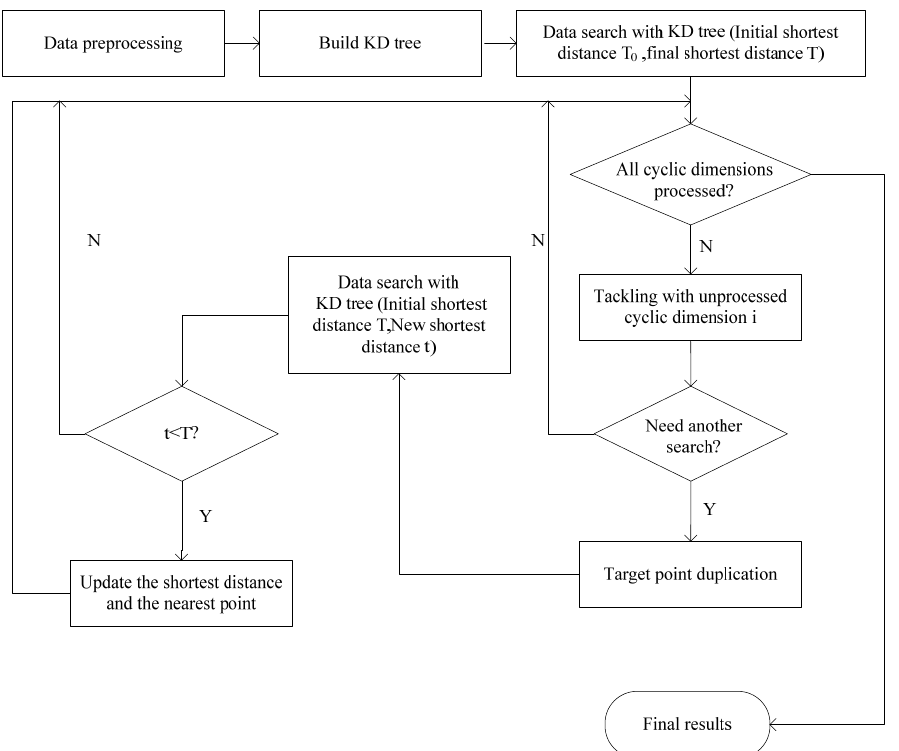
Figure 3. The process of the mirror method based on targets points duplication.